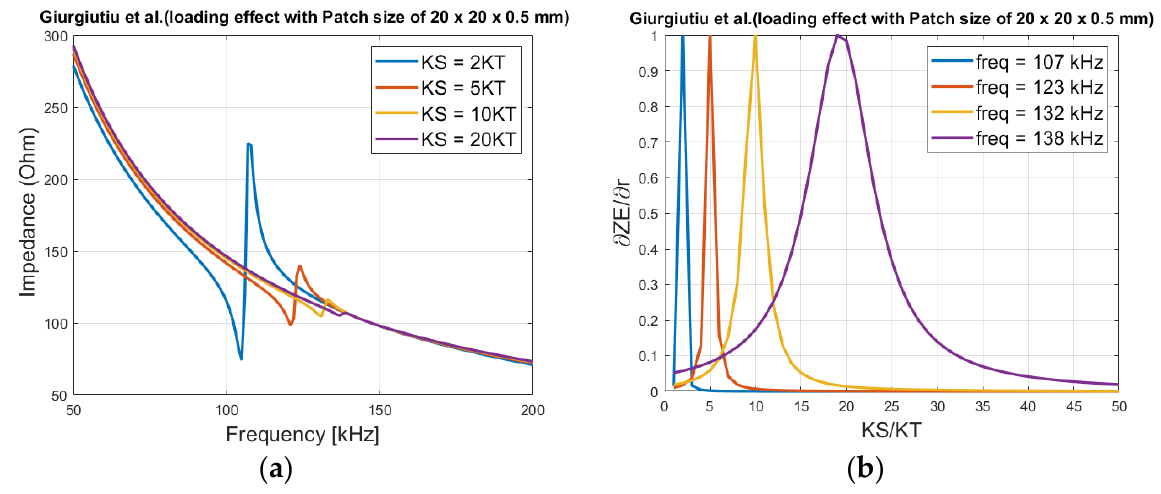
Figure 5. ( a ) Resonant areas of the impedance with patch size of 20 mm × 20 mm × 0.5 mm , ( b ) normalized derived of the real part of impedance as a function of the loading KS / KT .